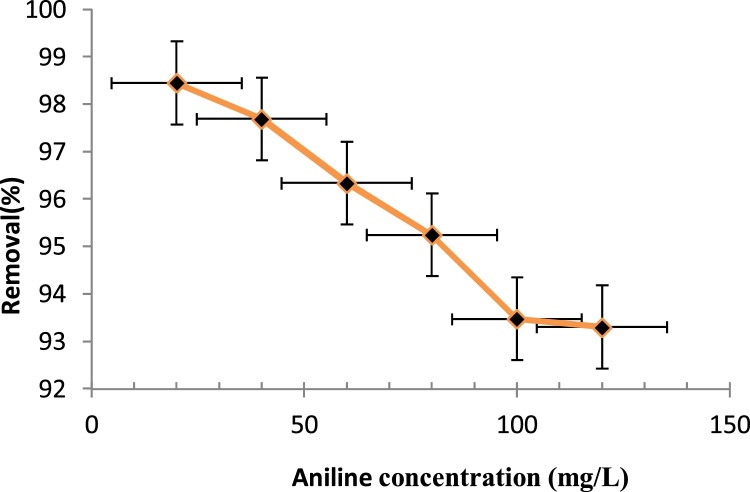
Effect of initial aniline concentration on the removal efficiency of aniline (Time: 45 min, H2O2 concentration: 0.01 mol/L, pH: 3).